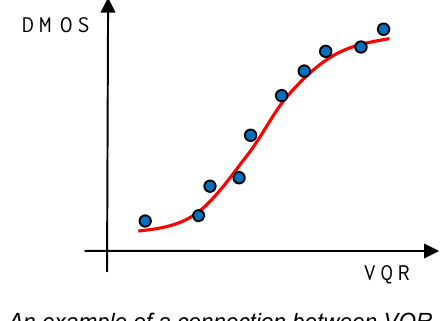
Figure 1 – An example of a connection between VQR and DMOS Рис . 1 – Пример связи между VQR и